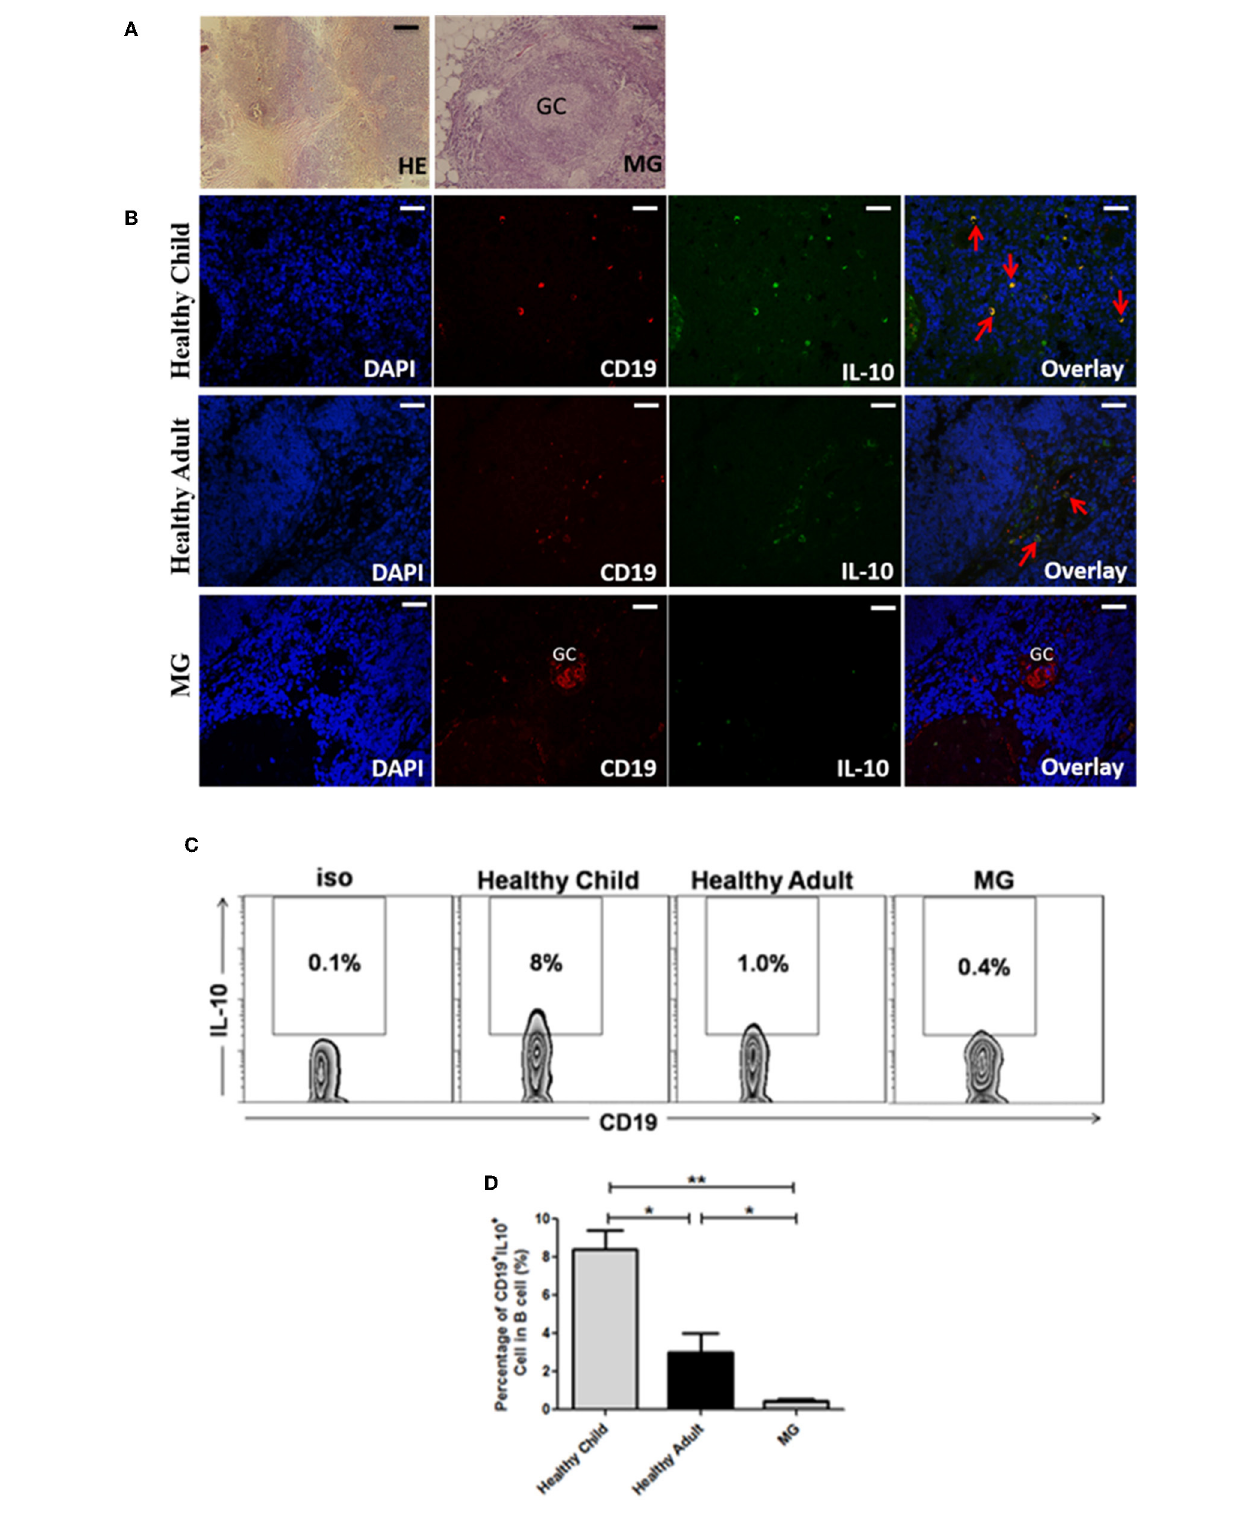
FIGURE 4 | CD19 + IL-10 + Breg cells were assessed in the thymus of healthy individuals and MG patients by immunofluorescence staining. (A) Human normal thymus and hyperplastic thymus from MG patients stained with hematoxylin and eosin. In addition, thymic hyperplasia was observed in an MG patient, which showed a germinal center (GC) structure (scale bars, 100 µ m). (B) Frozen sections of thymic tissues were immunoassayed with nuclear DAPI staining (blue). Double